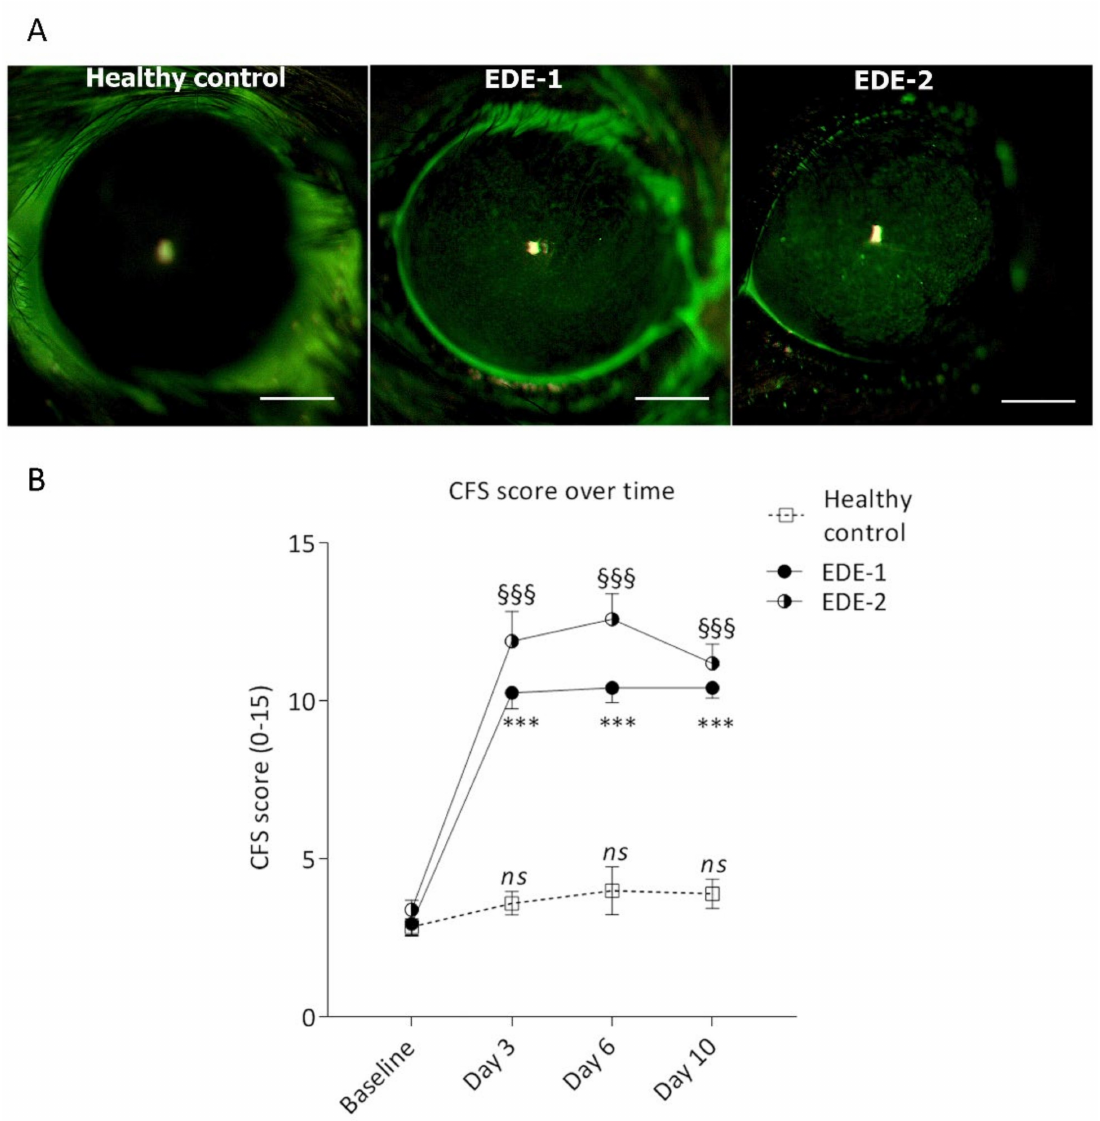
Figure 1. Evaluation of corneal alterations in both mouse models: ( A ) Representative photographs of mouse cornea after fluorescein staining at day (D) 10 following induction of dry eye; ( B ) corneal fluorescein staining (CFS) scores over time at D3, D6, and D10. Data are expressed as the mean ± SEM, and one-way ANOVA comparisons using the Kruskal–Wallis test were performed in each group against baseline *** p < 0.0001, §§§ p < 0.0001, respectively. EDE-1, mouse treated with scopolamine and placed in a controlled environment room; EDE-2, mouse following extraorbital lacrimal gland excision; CFS, corneal fluorescein